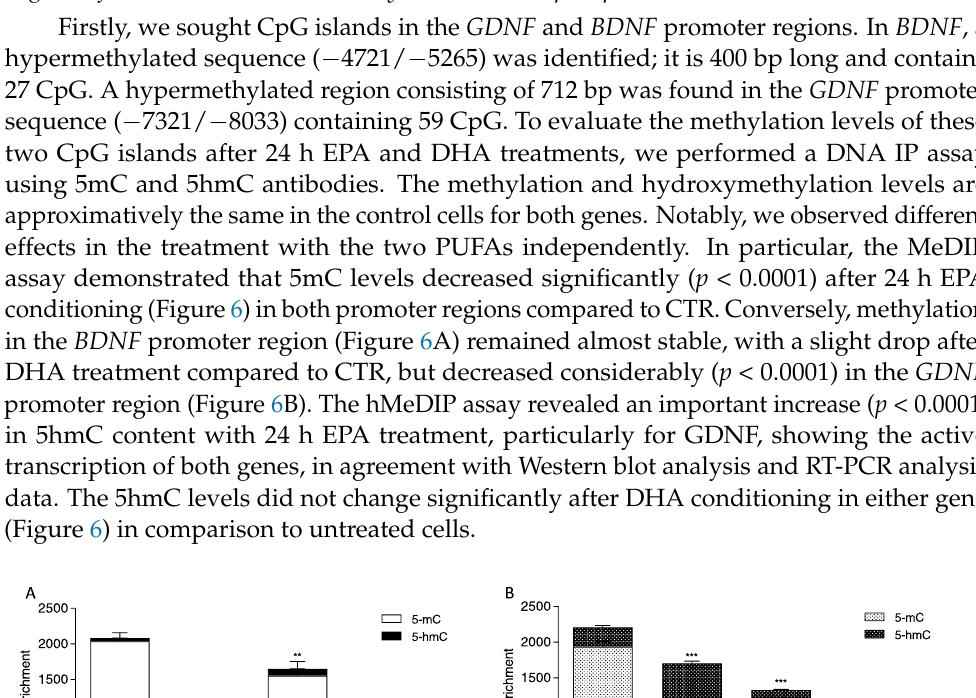
Figure 5. Effects of EPA and DHA alone and in combination with 6-OHDA on mRNA expression in SH-SY5Y cells. Cells were cultured and treated as reported in M&M. BDNF ( A ) and GDNF ( B ) gene expression levels were studied by RT-PCR. Glyceraldehyde 3-phosphate dehydrogenase (GAPDH) was used as a housekeeping gene. Experimental samples are reported as the mean ± SD. Data from three independent experiments using four independent cultures per condition were analyzed by ANOVA using Graphpad Prism software. * p < 0.01, ** p < 0.001, and *** p < 0.0001 . Regions of BDNF and GDNF Genes by DNA Immunoprecipitation (DNA IP)